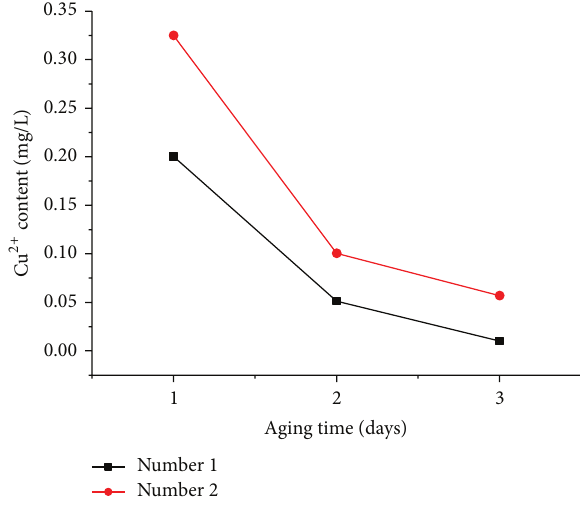
Figure 6: Effect of aging time on removal of